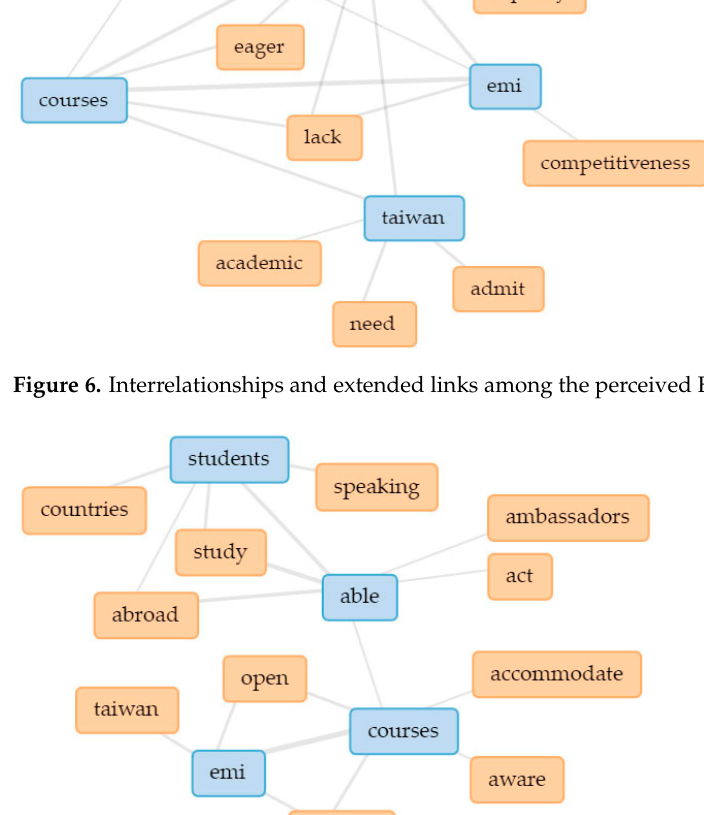
Figure 7. Interrelationships and extended links among the perceived EMI opportunities.